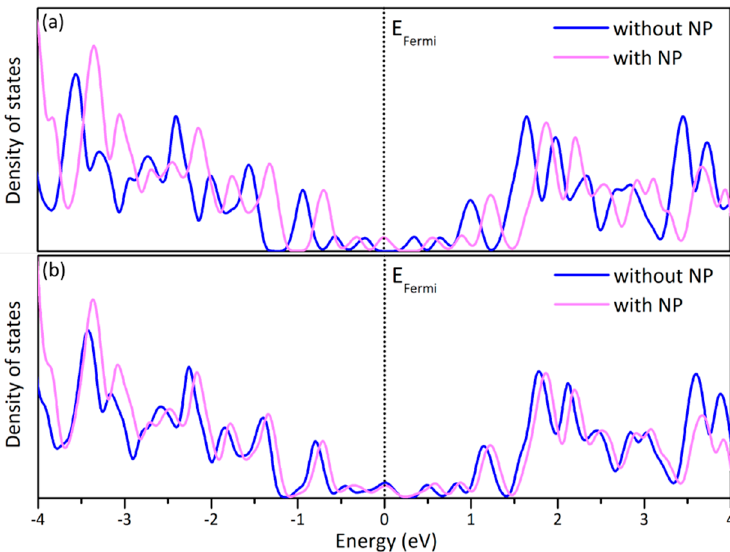
Figure 8. The partial density of states of the C atoms of ( a ) a pristine graphene sheet with and without an icosahedral Au NP oriented with a (111) facet parallel to the graphene sheet and ( b ) a graphene sheet with a vacancy with and without an icosahedral Au NP oriented with its vertex on the vacancy.